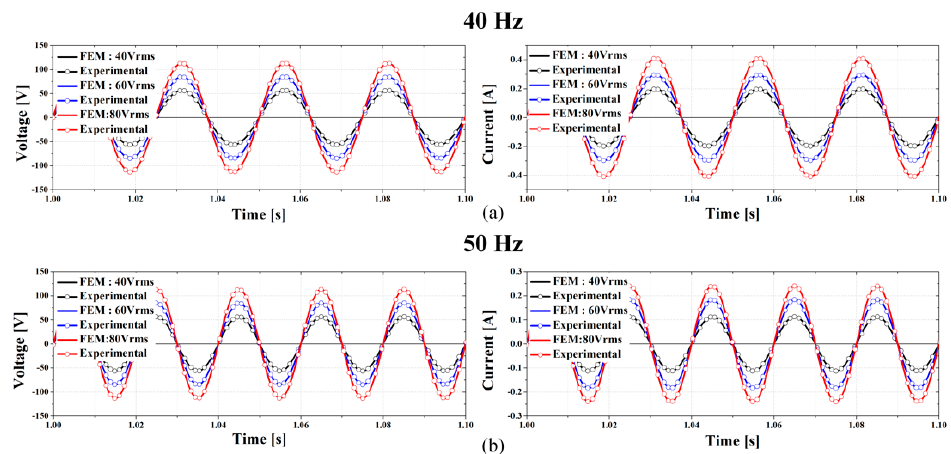
Figure 16. Voltage and current and analysis results and experimental results: ( a ) 40 Hz ( b ) 50 Hz.